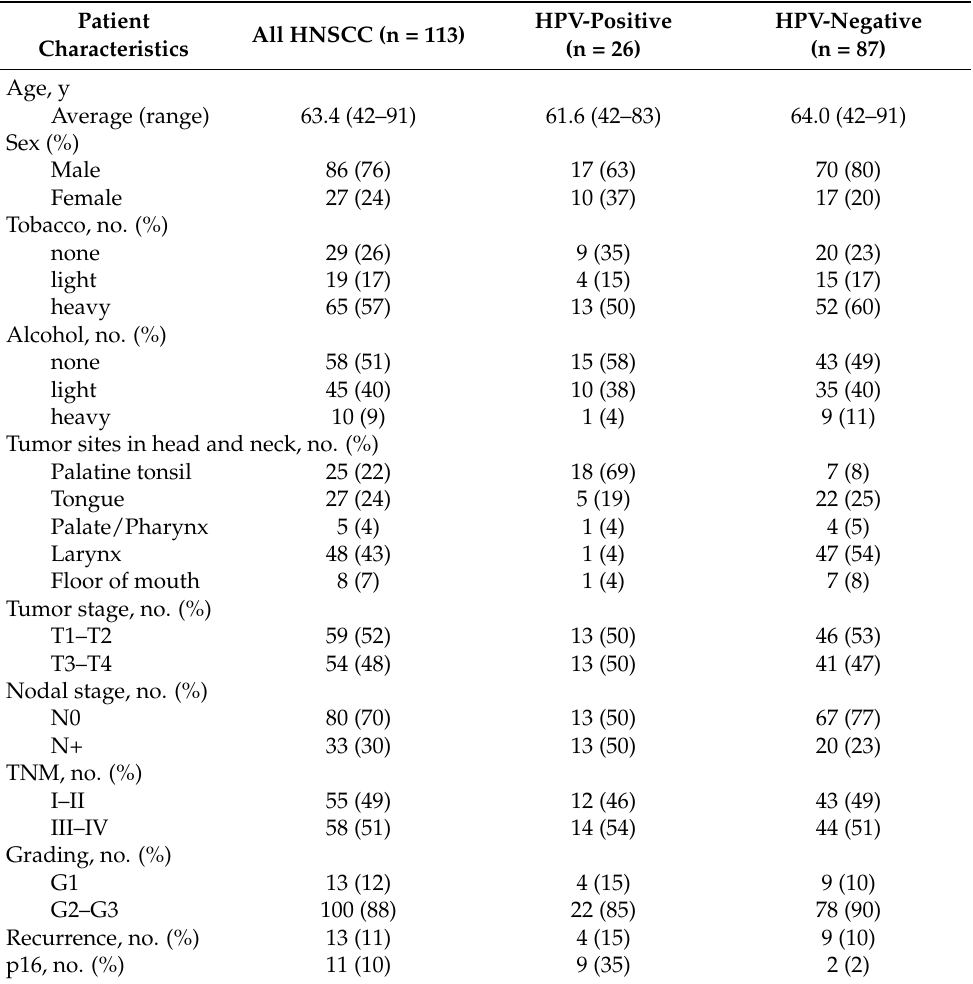
Table 1. Study group characteristics (Abbreviations: HNSCC—head and neck squamous cell carci- noma, HPV—human papilloma